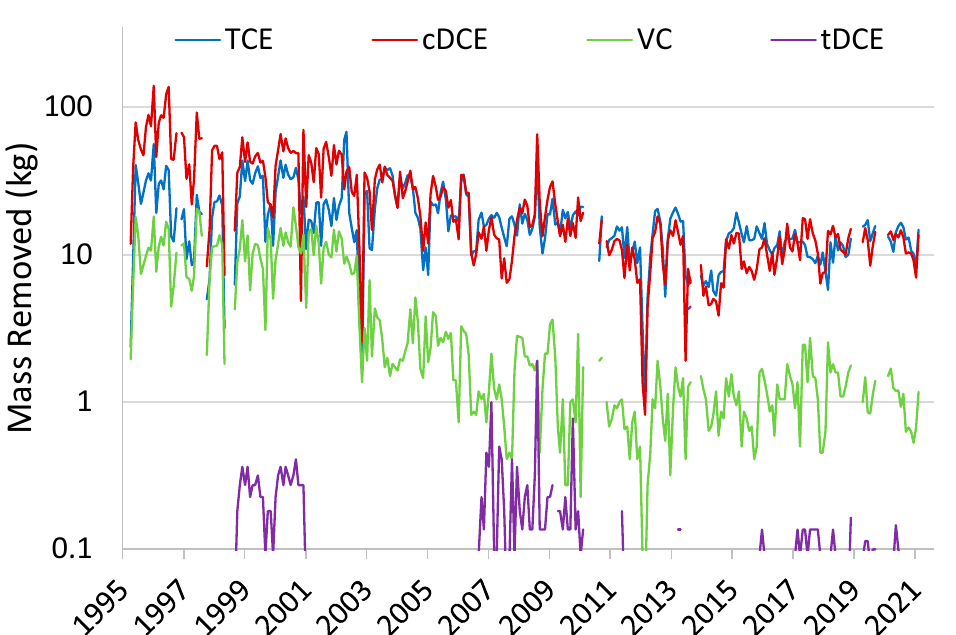
Figure 6. Monthly CVOC mass (kg) removed by the PAT system at the NAWC site. Data from 1995 to 2010 were taken from Lacombe [66], data from 2011 to 2020 were provided by the U.S. Navy, and data from 2020 to 2021 were taken from U.S. EPA monthly summary reports.